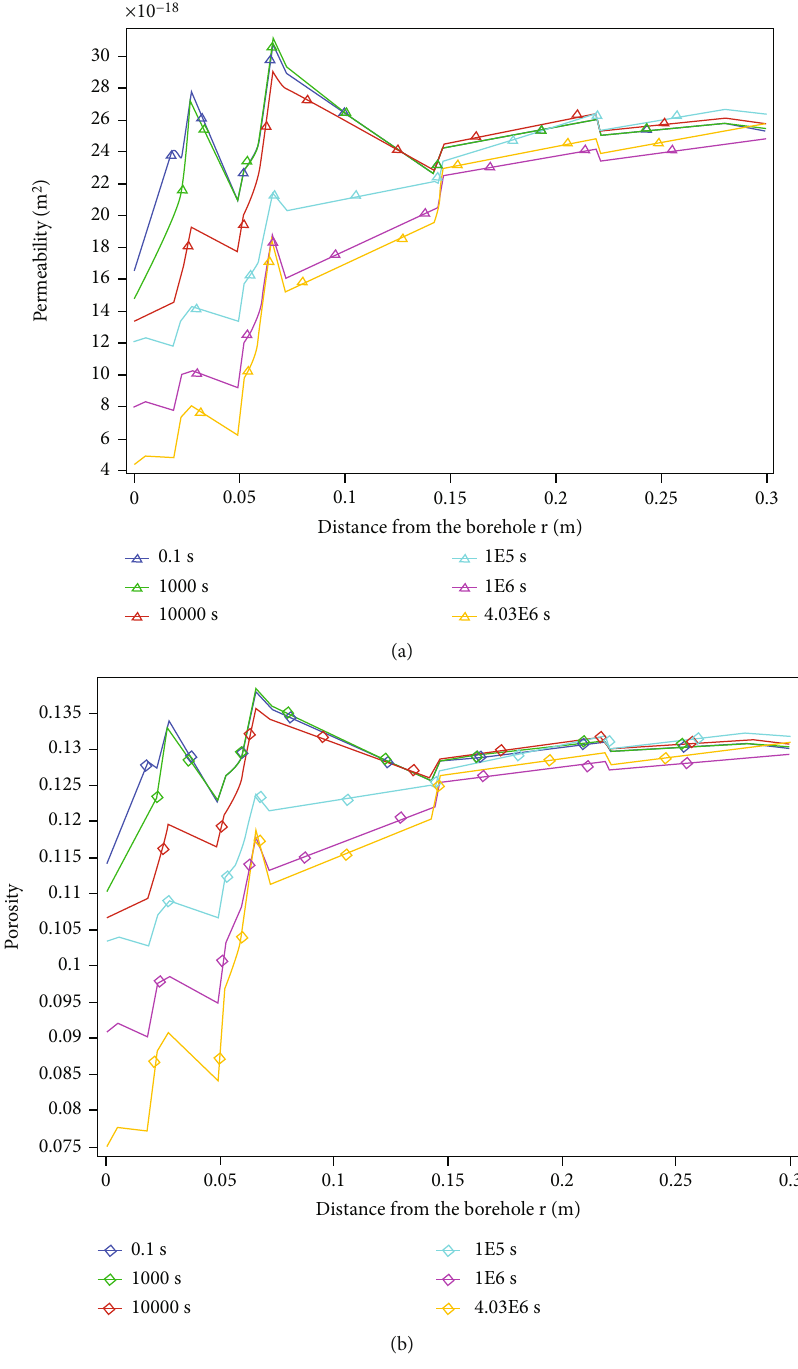
Figure 27: (a) Gas permeability and (b) porosity in the m = 1 coal rock during CBM